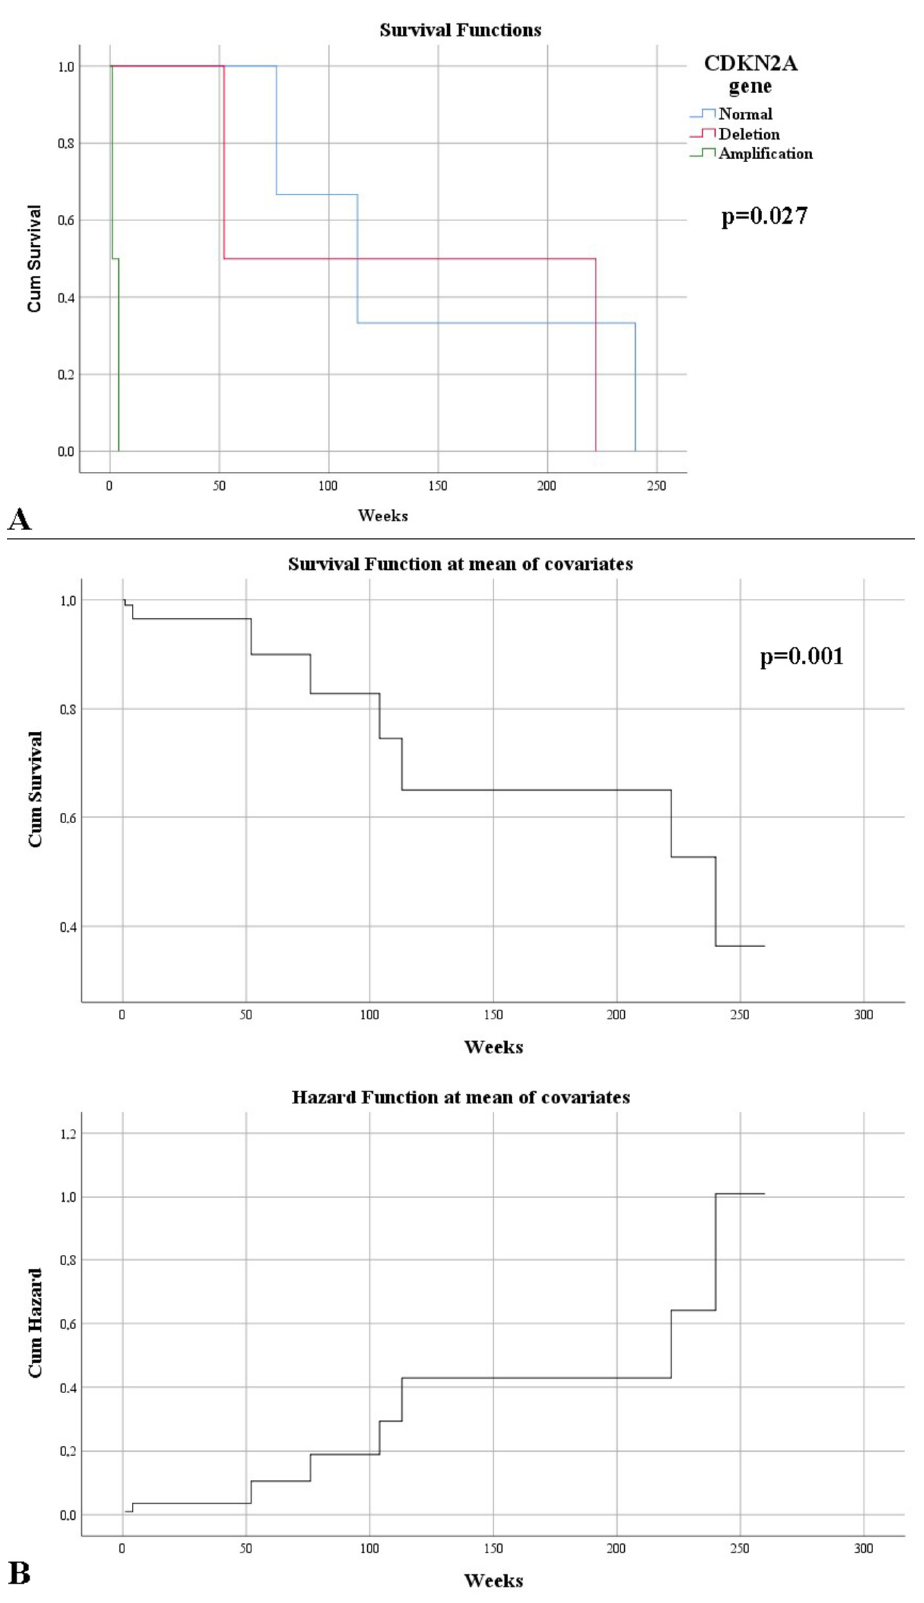
Figure 6. ( A ). Kaplan–Meier survival graphic that shows a lower survival rate in the case of CDKN2A mutations. ( B ). Univariate Cox regression analysis that expresses the risk of death in CDKN2A mutations.